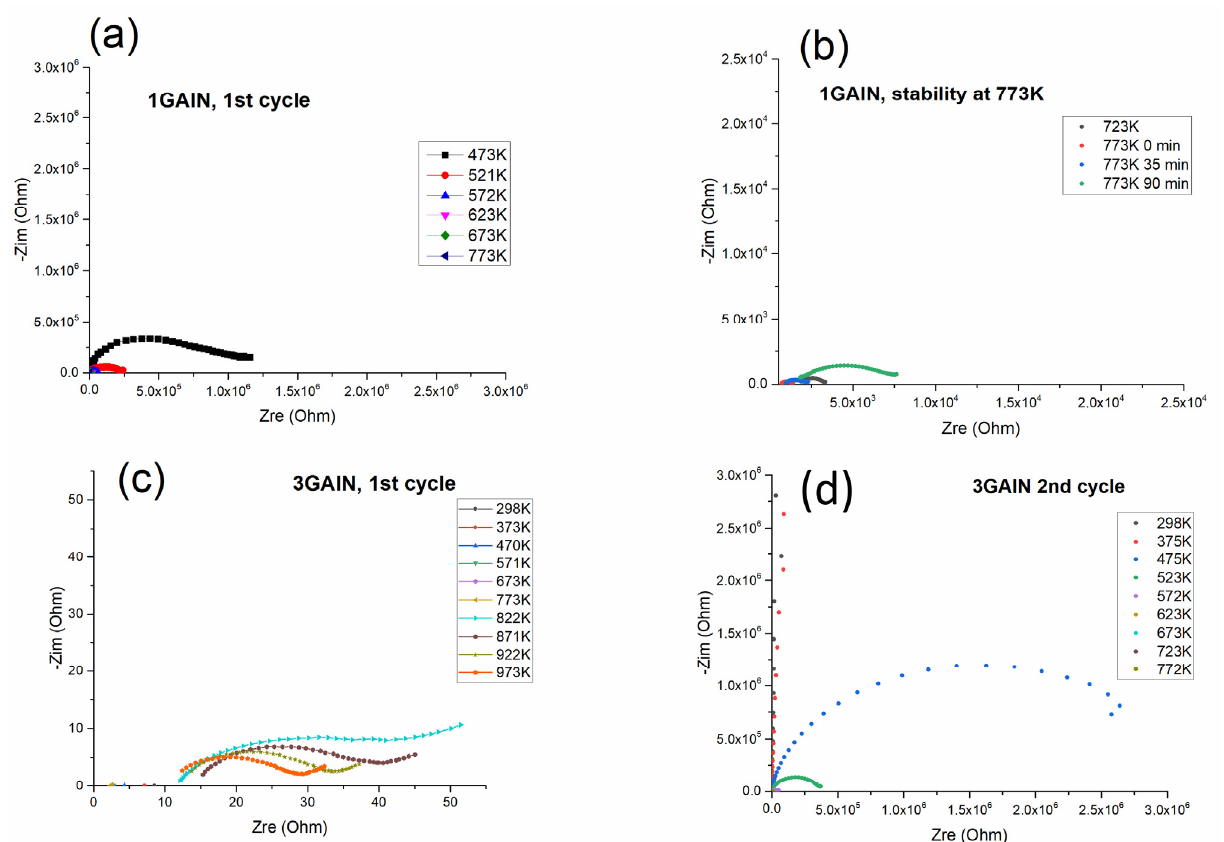
Figure 14. ( a ) impedance spectra for 1 GAlN during the first cycle of heating/cooling, ( b ) evolution of impedance spectra for 1 GAlN at 723 and 773 K; ( c ) impedance spectra for 3 GAlN during the first cycle of heating/cooling; ( d ) impedance spectra for 3 GAlN during the second cycle of heat- ing/cooling.